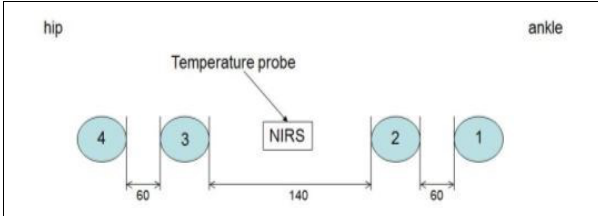
Fig. 1B: Placement of ECG electrodes for leg bioimpedance measurements.